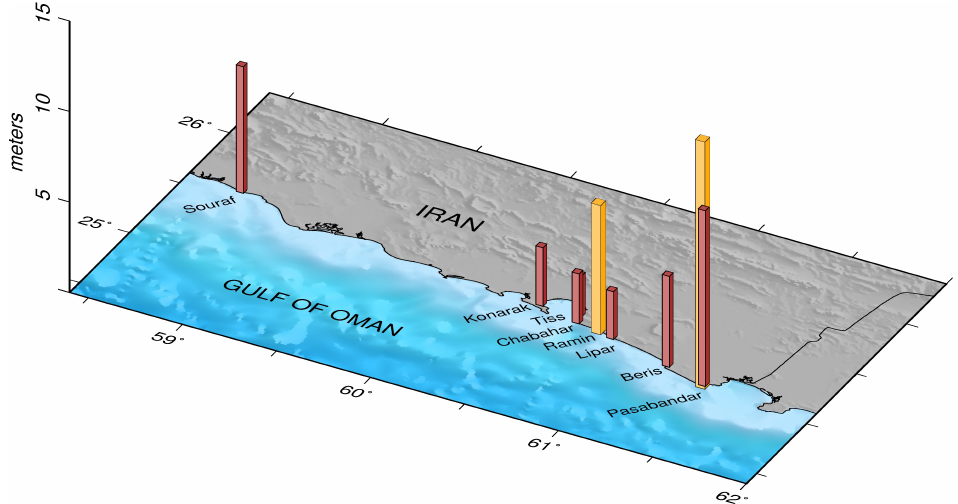
Figure 4. The results of the 2010 fieldwork by Okal et al. [37] in terms of estimated run-up (brown bars) or splash (orange bars) caused by the 1945 Makran tsunami for nine locations along the coastline of Iran (modified after